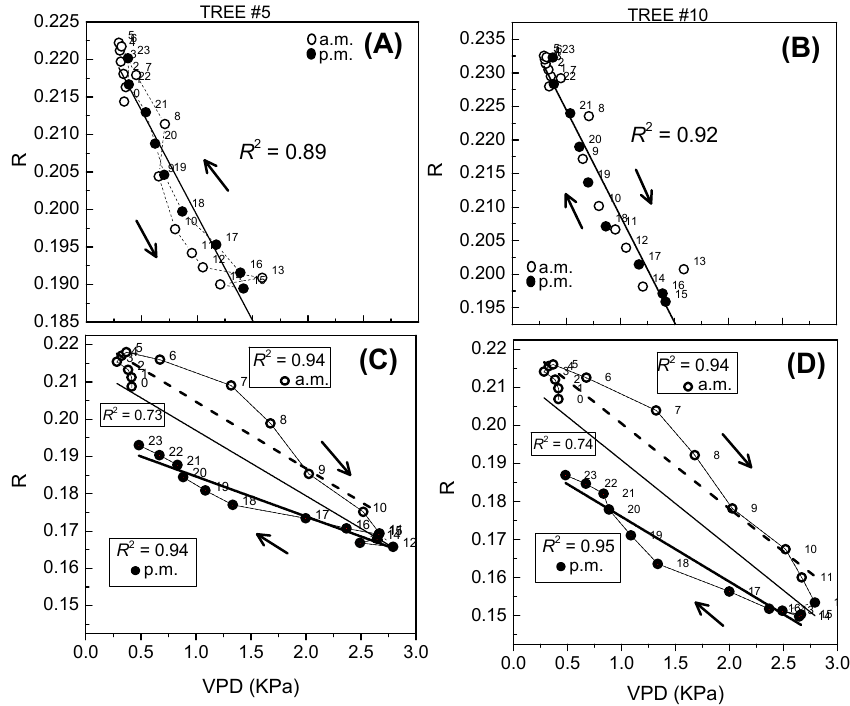
Figure 3. Example of diurnal variation of R in tree #5 ( A , C ) and #10 ( B , D ) plotted against VPD recorded during days with maximum high VPD ( C , D ) and low ( A , B ) highlighting the hysteresis of R between a.m. ( ○ ) and p.m. (•) data. Note that a.m. and p.m. values in each panel were pooled before fitting (continuous mild line) and R 2 determination. For panel ( C , D ) additional fittings were performed separately for a.m. (bold continuous line) and p.m. (bold dashed line) data. The numbers close to the symbol indicate the day hour when data have been recorded. Arrows indicate the time course of the day from 0 to 23 h.